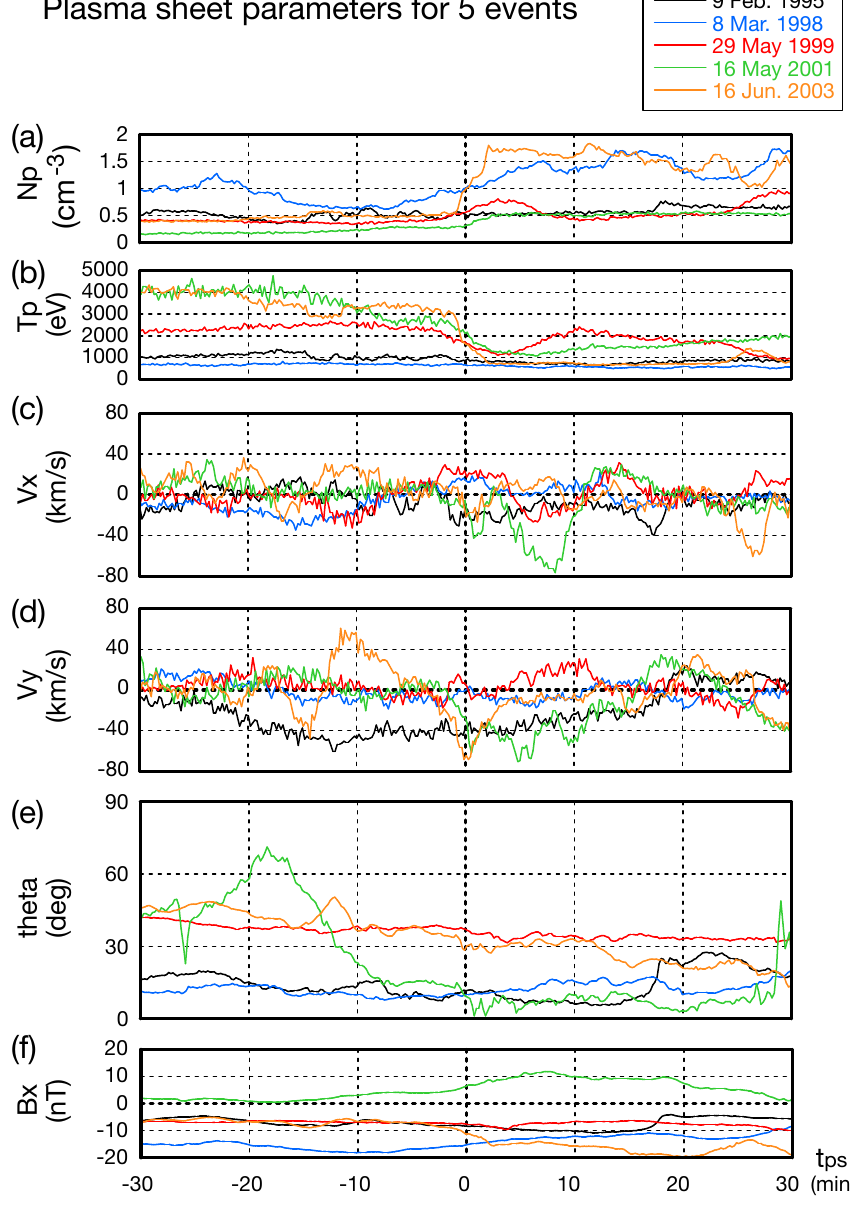
Fig. 12. Superposed plots of the plasma sheet parameters for the 5 events. From the top, (a) proton density, (b) proton temperature, (c) V X , (d) V Y , (e) latitudinal angle of the magnetic field, (f) B X are shown. The zero of the horizontal axis ( t PS ) corresponds to the emergence of the two-component